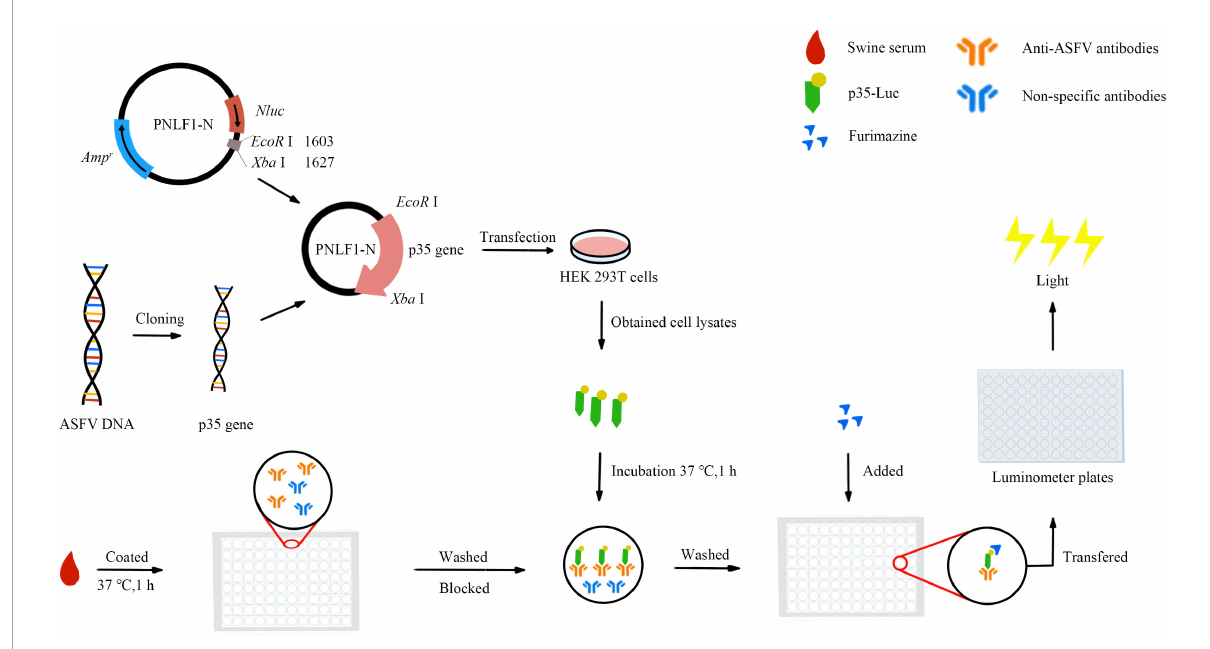
FIGURE1 Schematic of the operation procedure of the improved p35-Luc LISA assay.